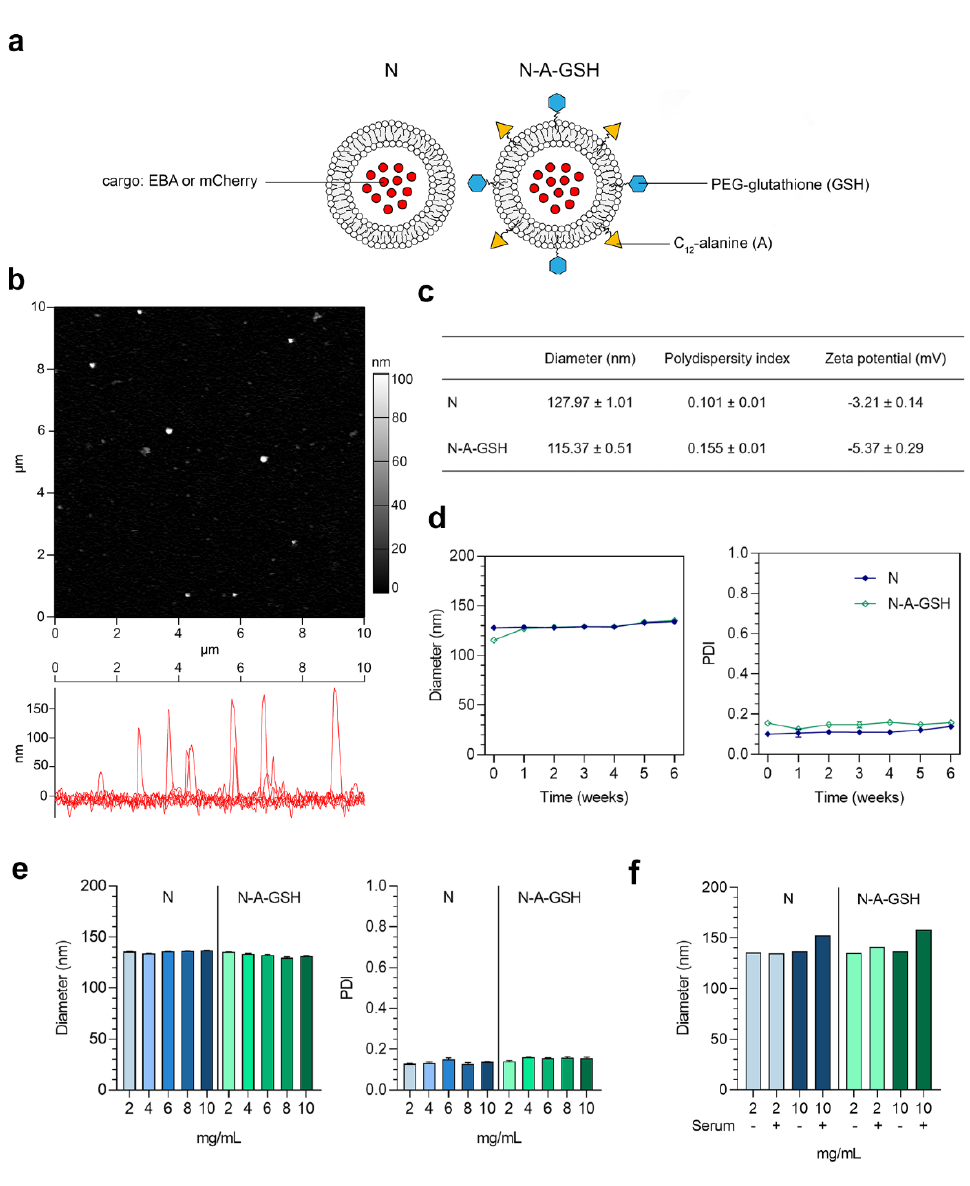
Figure 2. ( a ) Schematic drawing of non-targeted (N) and alanine-glutathione targeted (N-A-GSH) niosomes. EBA: Evans blue-albumin complex. ( b ) Atomic force microscopy image of N-A-GSH niosomes. ( c ) Main physico-chemical properties of niosomes. Values presented are means ± SD. ( d ) Size stability of niosomes over time at 2 mg/mL concentration, ( e ) at week 12 with increasing NP concentrations and ( f ) in PBS with or without 10% FBS. PDI: polydispersity index. Values presented are means ± SD.